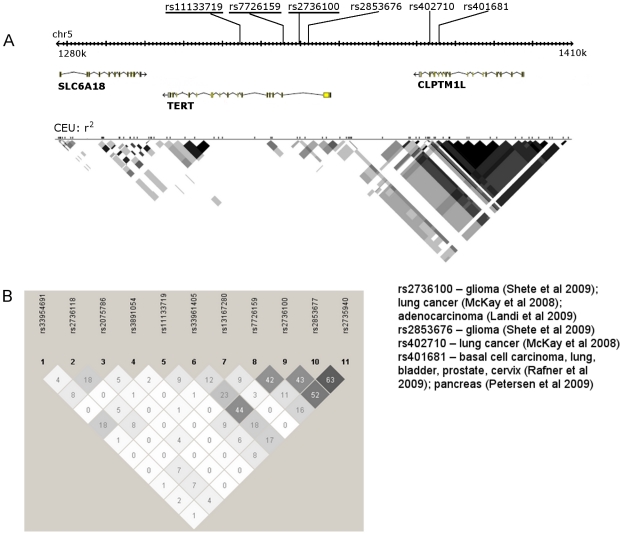
Gene map and LD plot of TERT-CLPTM1L locus and associated SNPs.Colour scheme is based on r2 values in Haploview; white r2 = 0; shades of grey 0<r2<1; black r2 = 1. Block definition is based on the method of Gabriel et al [54]. (A) Gene map of SNPs genotyped in the discovery stage (underlined) relative to other TERT SNPs associated with cancer phenotypes (inset) and LD plot based on HapMap CEU samples. (B) Haploview plot of all TERT SNPs genotyped in 1,047 non-Hispanic White controls in our study; numbers in squares are pairwise r2 values between SNPs.